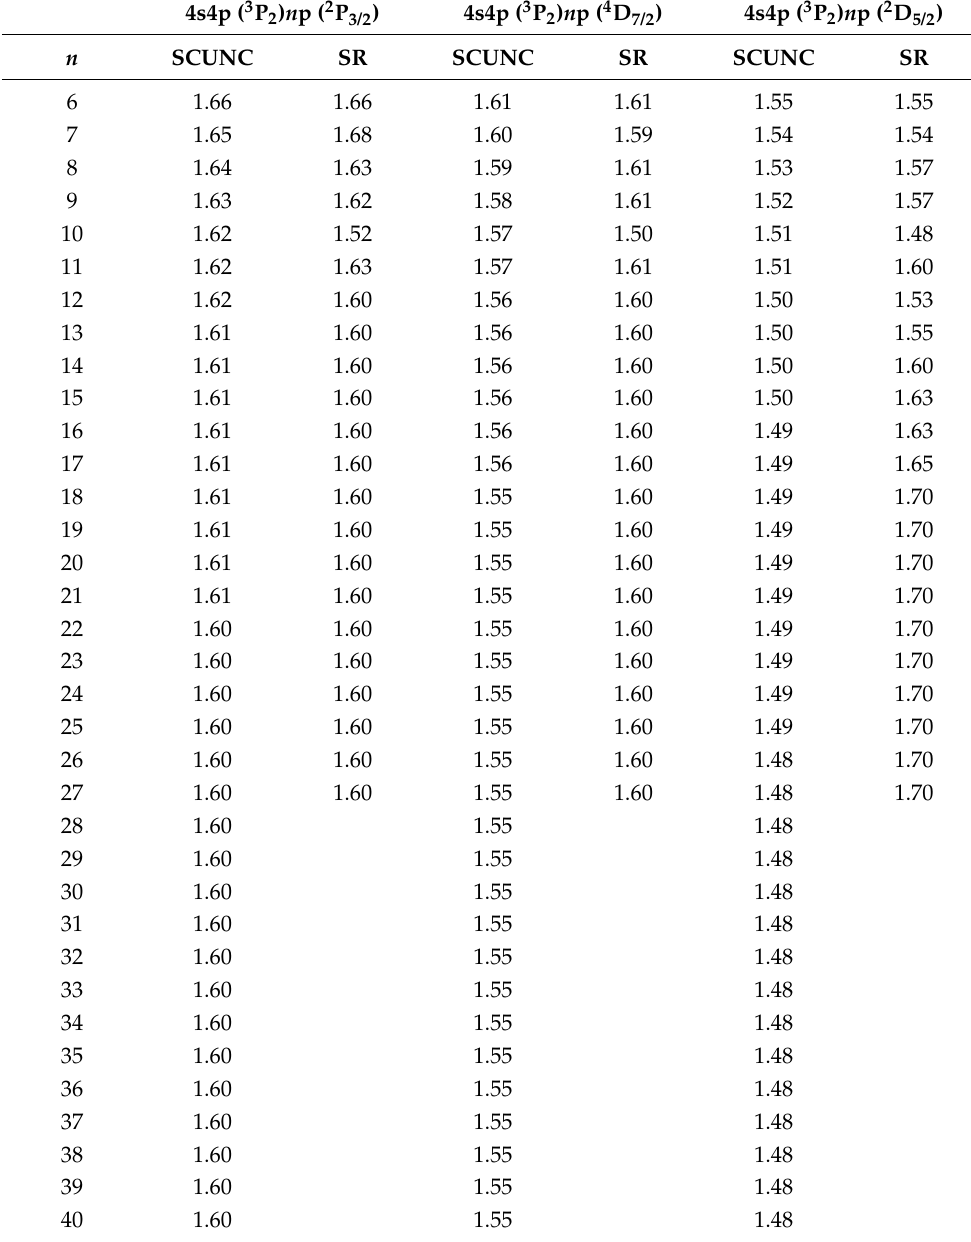
Table 4. Quantum defects (dimensionless) of the 4s4p ( 3 P 2 ) n p ( 2 P 3/2 , 4 D 7/2 , 4 D 5/2 ) Rydberg series originating from the 4s 2 4p 2 P 3/2 states of Se 3+ converging to the 3 P 2 series limit in Se 4+ . The SCUNC results are compared to the SR measurements of Esteves et al.